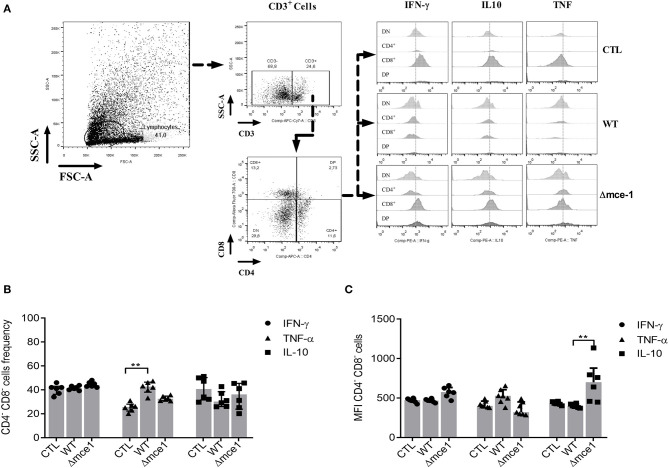
IFN-γ-, TNFα- and IL-10-producing by CD4−CD8− double negative (DN) T cells from six healthy donors in a co-culture assay. Non-adherent cells were added to a culture containing adherent cells exposed to apolar lipids extracted from wild type vs mce1 operon mutant M. tuberculosis. (A) The gating strategy to assess the DN T cells and cytokine production by each cell population. (B) Frequency of IFN-γ-, TNFα-, and IL-10 produced by DN T cells. (C) Quantification of the mean fluorescence intensity of IFN-γ-, TNFα-, and IL-10-producing DN T cells. Results are expressed as median ± IQR; n = 6/group. Statistical significance was determined by Friedman test followed by Dunn's post-test; significance was considered at **p < 0.01. WT, Mtb wild type strain; Δmce1, Mtb strain disrupted in mce1 operon; CTL, no stimulus.